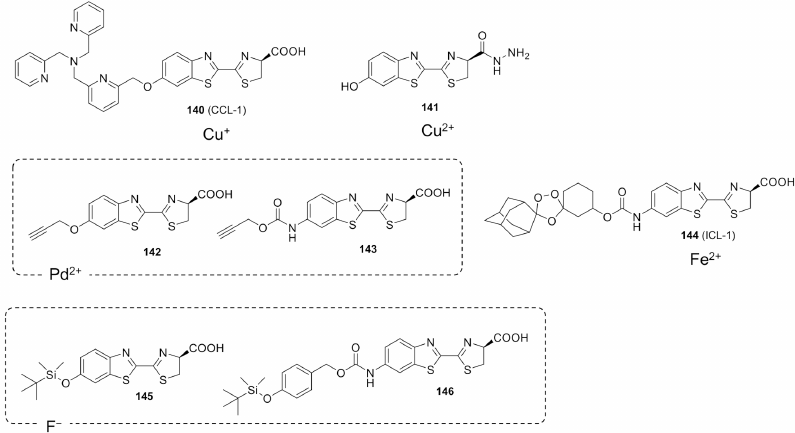
Figure 8. Chemical structures of bioluminescence probes for